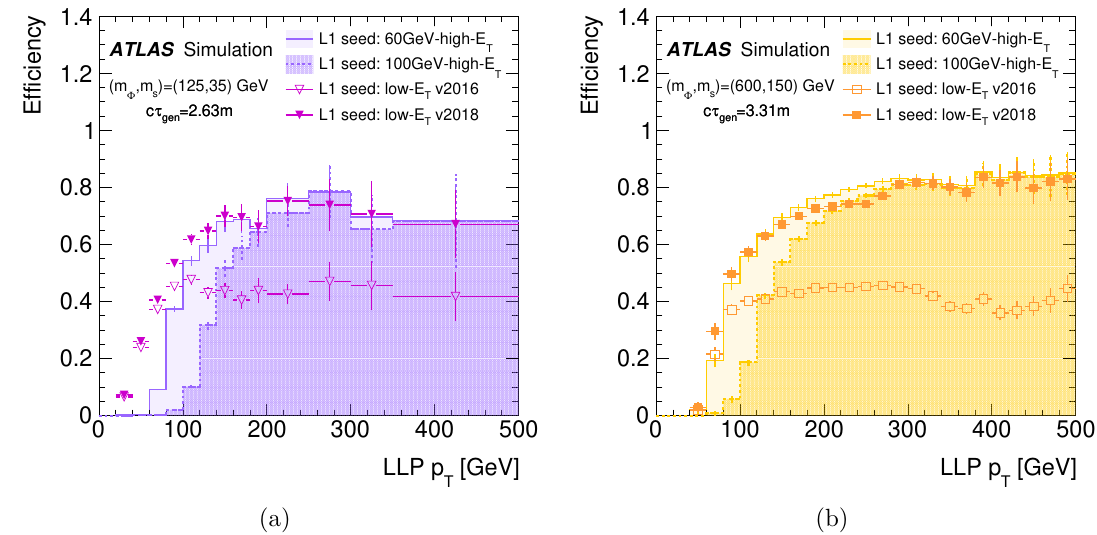
Figure 2. Trigger efficiency for simulated signal events as a function of the LLP p T for (a) one of the low- E T signal samples and (b) one of the high- E T signal samples for HLT CalRatio triggers seeded by the high- E T L1 triggers with E T thresholds of 60 GeV and 100 GeV and by the two versions of the low- E T L1 triggers. Only statistical uncertainties are